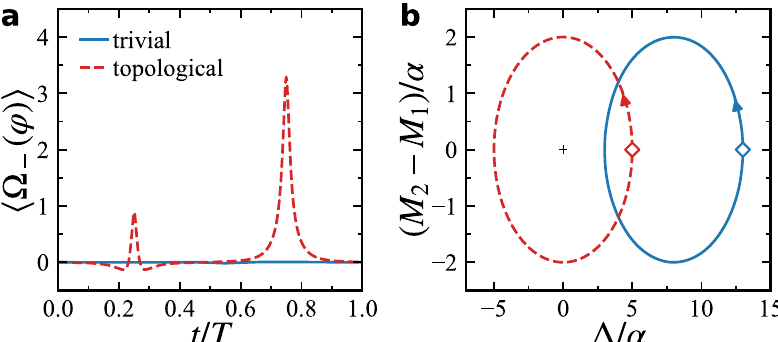
Fig. 2 Dynamic evolution in one period of pump cycling. a Evolution of the averaged Berry curvature 〈 Ω − ( φ ) 〉 . The blue-solid and red-dashed lines show the cases of the trivial pump with Δ 0 = 8 α and the topological pump with Δ 0 = 0, respectively. The pump starts at t i = 0 and ends at t f = T . We set M 0 = − 0.2 α , α 0 ¼ 5 α , and φ 0 = 0. b The corresponding trajectories of the evolution in the parameterized plane between Δ ( t ) and M 2 ( t ) − M 1 ( t ). The diamonds mark the positions before the pump, and the arrows show the directions of the trajectories. The plus symbol marks the singular point where the Berry phase is ill de fi ned. Only the trajectory of the topological pump encloses the singular